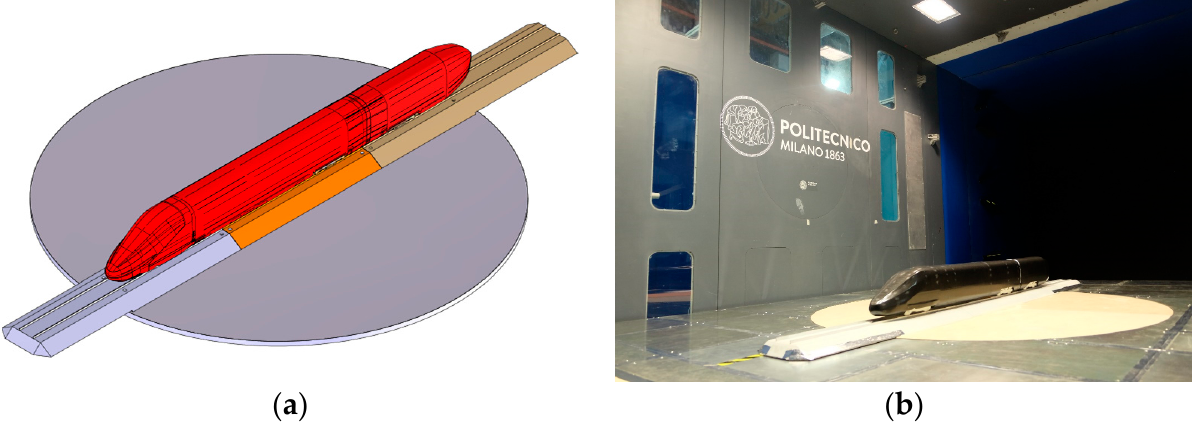
Figure 2. Wind tunnel model of ETR1000: ( a ) CAD model; ( b ) scaled model on GVPM wind tunnel.